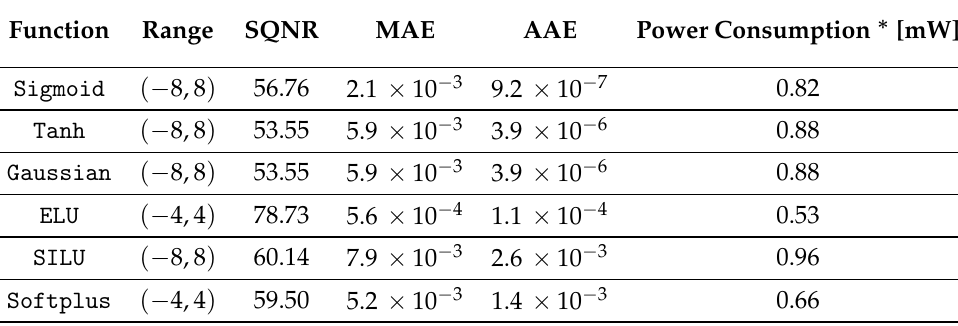
Table 12. Hardware performance for the implemented PPA-ED-based